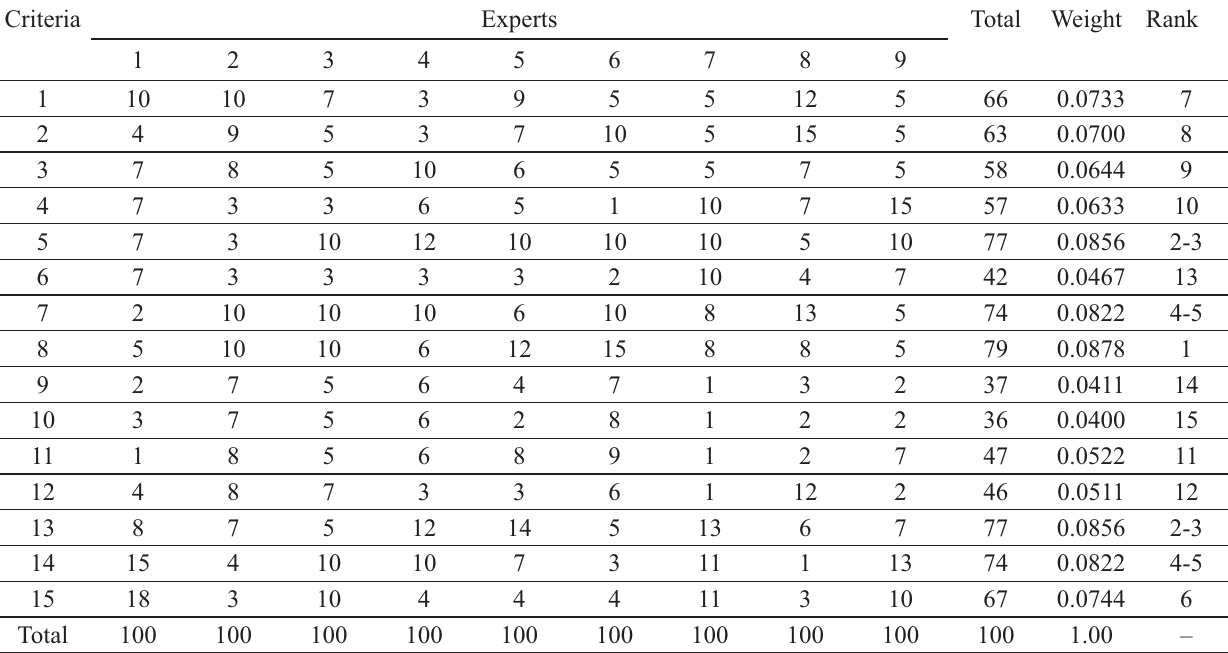
Table 6. Direct evaluation of the criteria weights (signifi cances) by experts